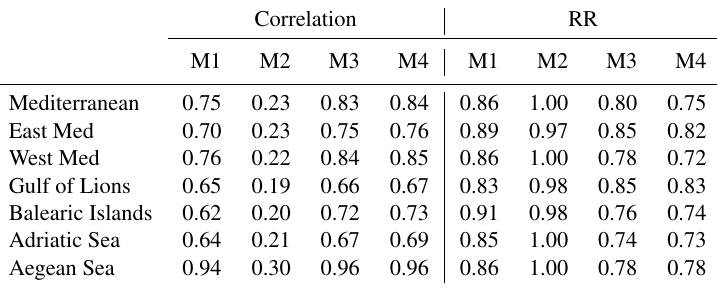
Table 3. Temporally averaged regional correlation and RR of the different forecasting models (M1–M4) applied in different regions (see Fig.